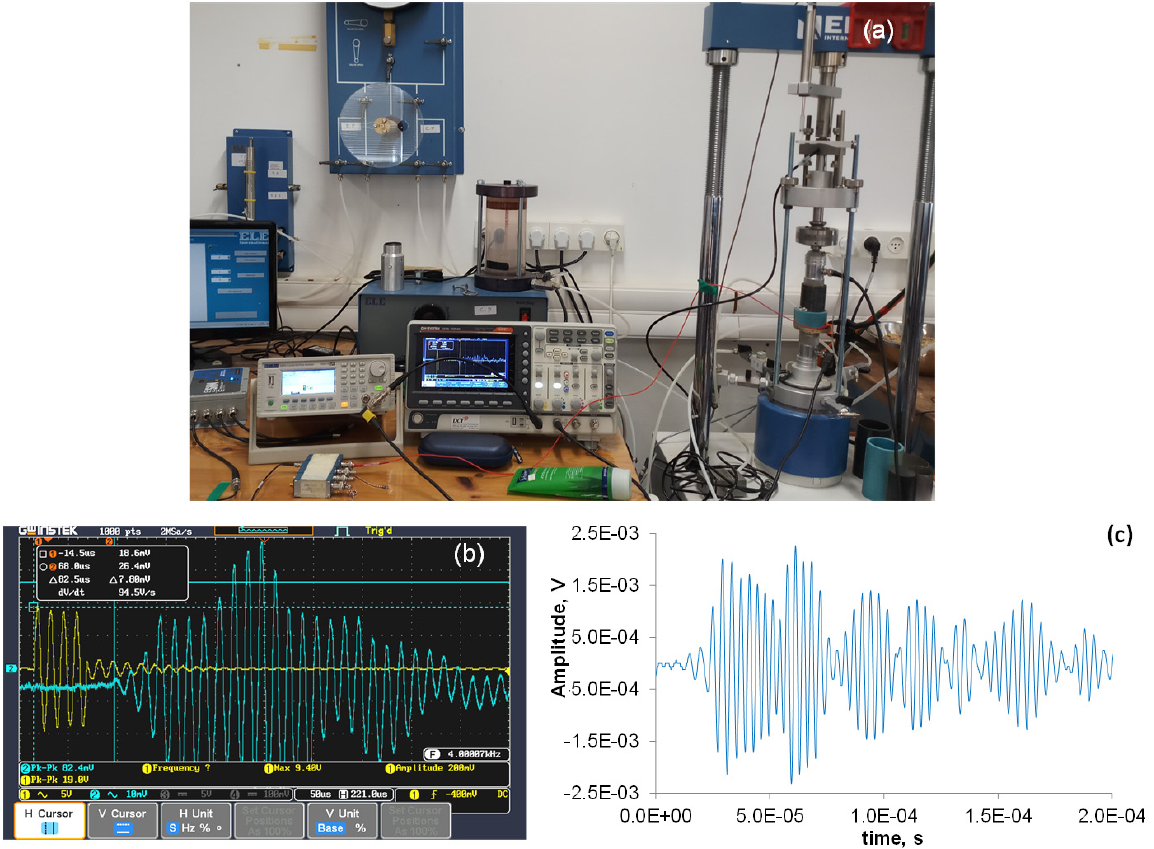
Figure 4. ( a ) Indicative snapshot during one of the modified uniaxial tests with passive confinement. ( b ) Indicative screenshot of the US signals measured by the digital oscilloscope. ( c ) Indicative AE signal acquired during the experiments. Note that in the used number format, the notation “E ± xx” is part of a scientific notation and corresponds to “ · 10 ± xx